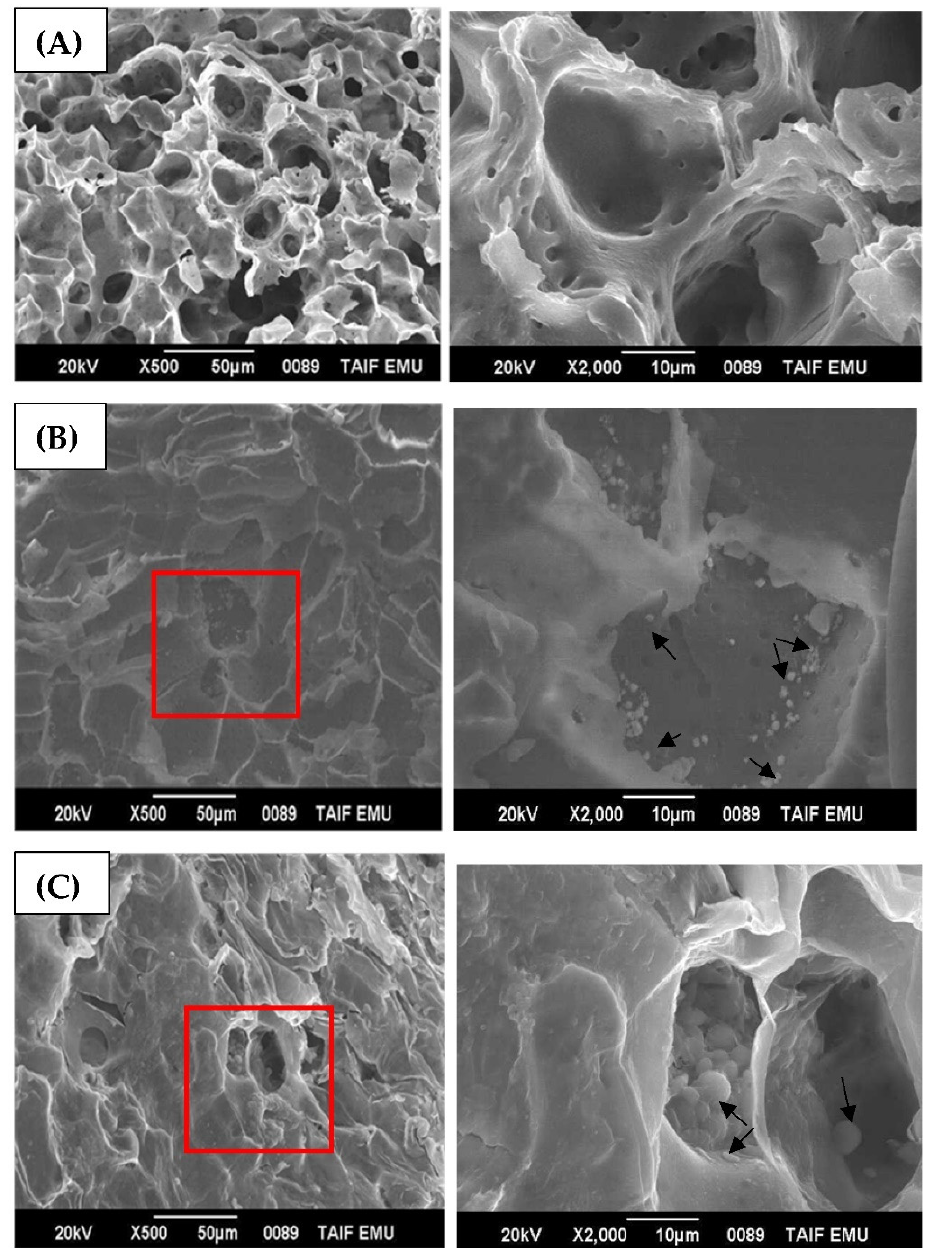
Figure 4. SEM micrographs of primed P. granatum seeds at different magnifications. ( A ) hydroprimed seeds; ( B ) TiO 2 NPs_ PPE-primed seeds; and ( C ) TiO 2 NPs_CE-primed seeds (red box and arrows show the adsorbed nanoparticles on seed coat surface) .